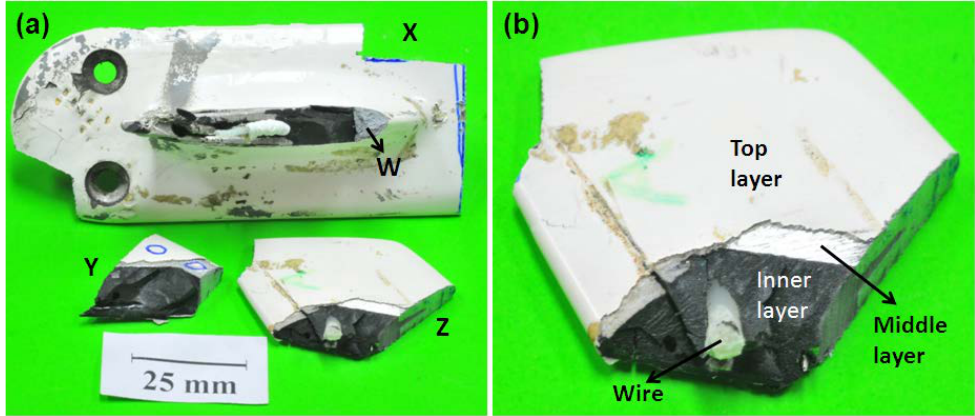
Figure 6: Broken pieces of the damaged antenna: (a) all pieces together and (b) close view of the Z in (a).